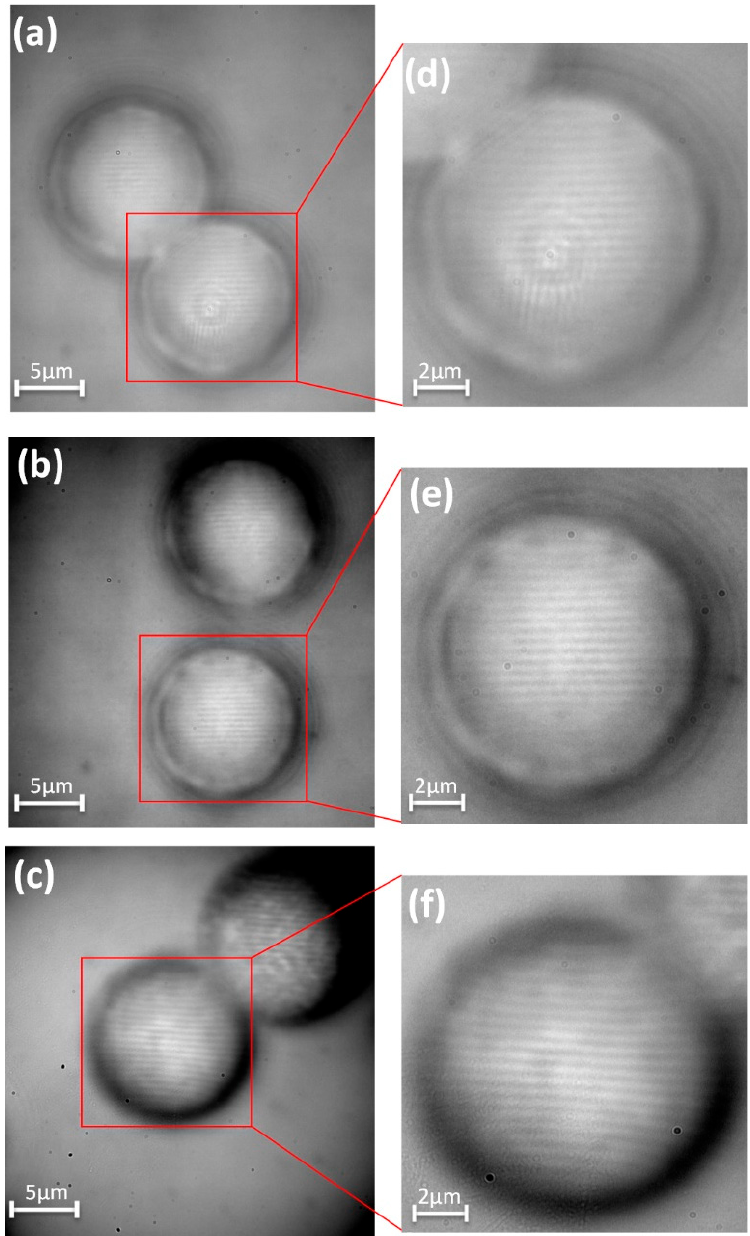
Figure 5. Super-resolution images of the SNG using an optically trapped 10- μ m-diameter PS/MF sphere. ( a ) The SNG image assisted by an optically trapped 10- μ m-diameter PS sphere without a filter, in which the focused laser spot affects the imaging. ( b ) The SNG image by the trapped PS phere, in which a short-pass filter is used to eliminate the focused laser spot, and the un-trapped PS sphere moves away from the trapped one when moving the sample stage. ( c ) The SNG image assisted by a trapped 10-um MF sphere. ( d – f ) zoom-in of ( a – c ), respectively. With the trapped PS/MF sphere, we can visualize the sub-diffraction-limited grating structures, and the image by the MF sphere ( f ) shows a better imaging quality compared to that by the PS sphere ( e ). The sphere in the red frame is optically trapped and is kept motionless when moving the sample.